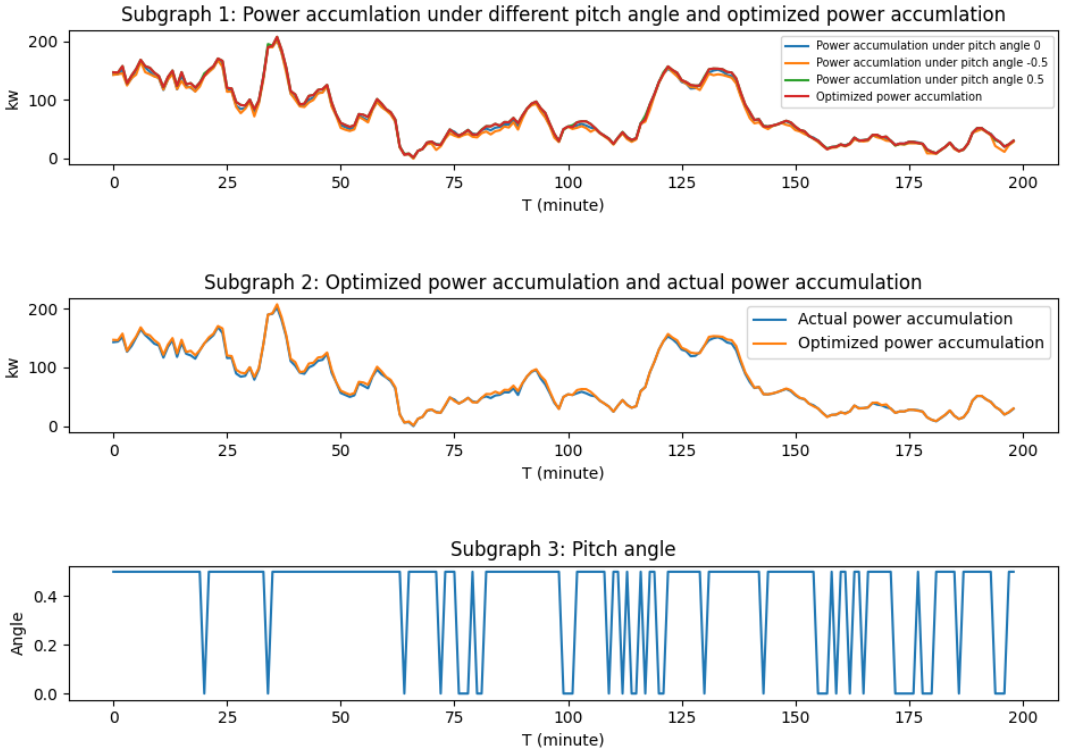
Figure 10. Partial power optimization results for #70 with T = 1min.